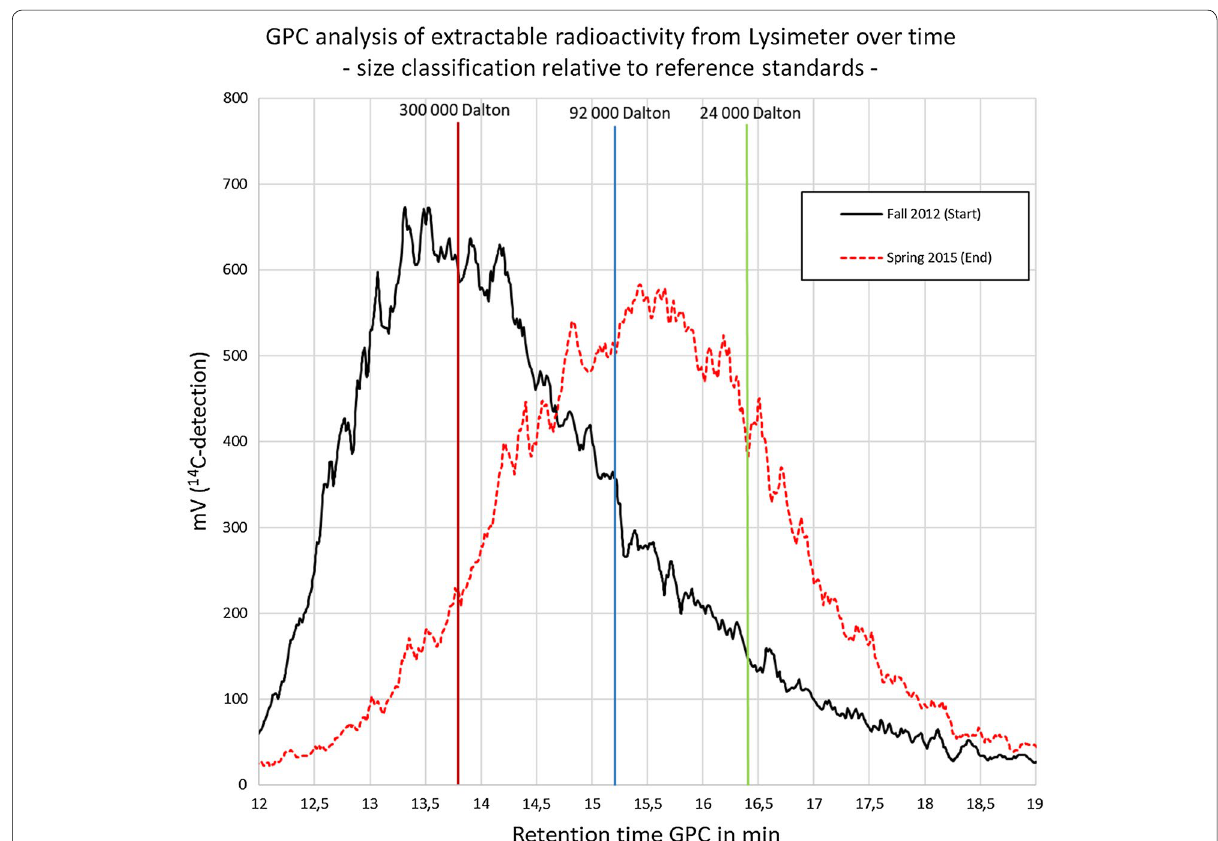
Fig. 2 Lysimeter-extract at test start and test end with standard retention times. Vertical lines ards: red: SaSt140317-AS (300,000 Da), 13.8 min; blue: SaSt140317-BS (92,000 Da), 15.2 min; green: SaSt140317-CS (24,000 Da), 16.4